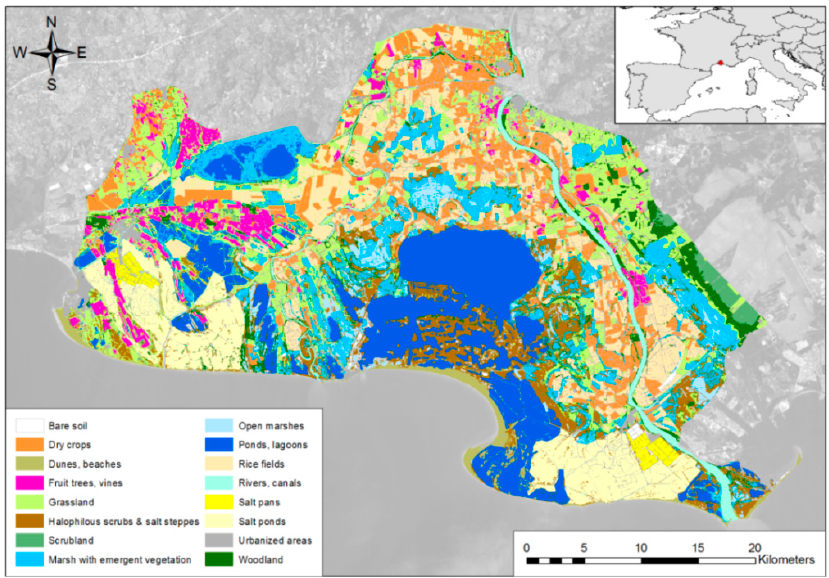
Figure 1. Simplified land cover map of the Camargue Unesco Man and Biosphere reserve built from maps provided by the Syndicat Mixte de Camargue gardoise and Parc naturel régional de Camargue based on orthophotographs of 2011 and 2016, respectively.